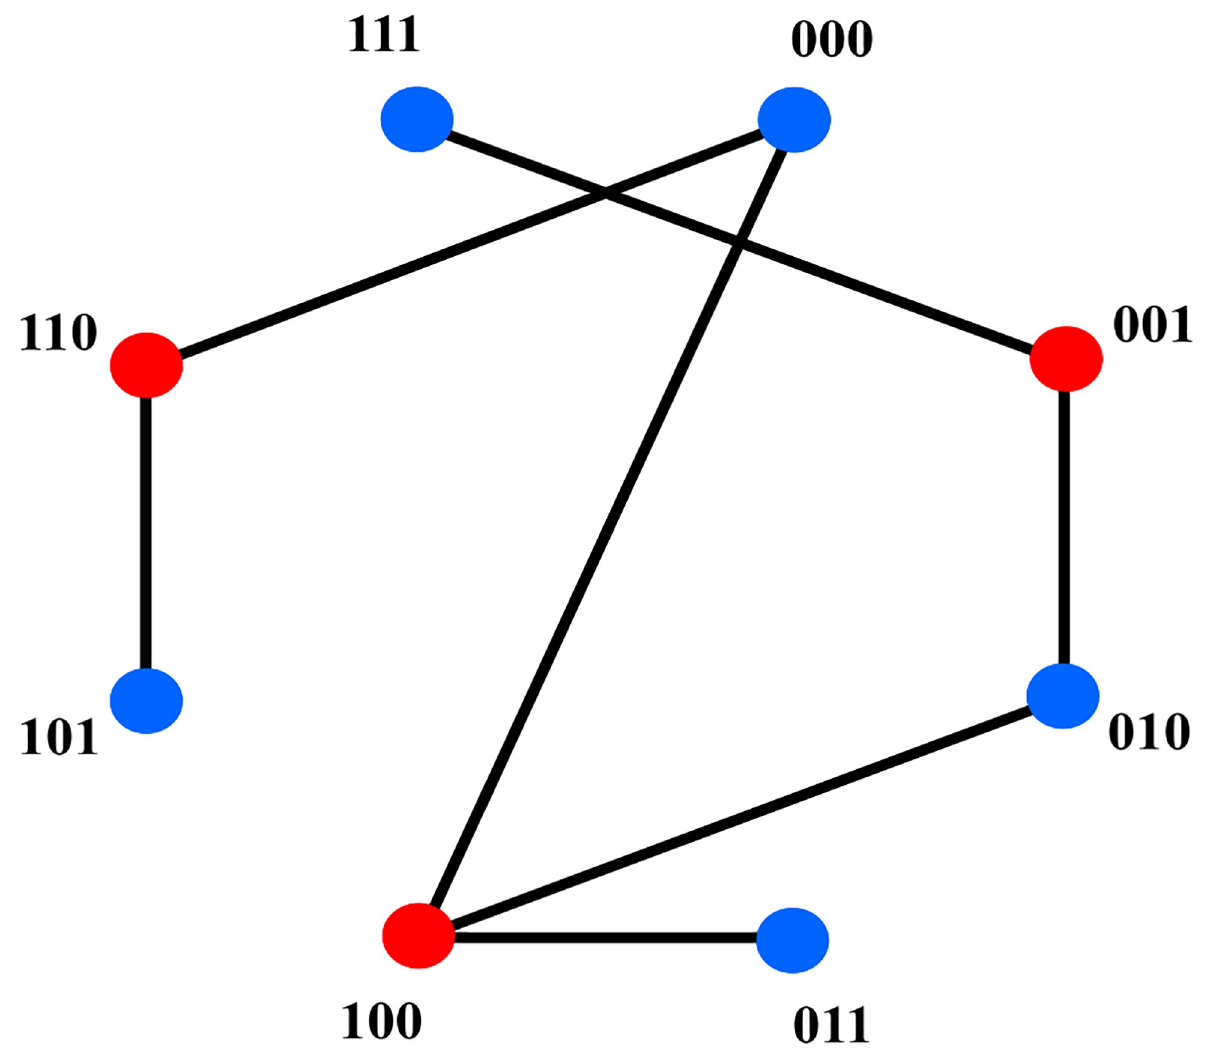
Fig 3. A 2-colorable graph representing the i-o function of a black-box module. Vertices of the graph denote all inputs of the module. Different colors of the vertices represent different outputs of the module. The graph has 8 = 2 3 vertices because the module takes three binary variables as inputs.